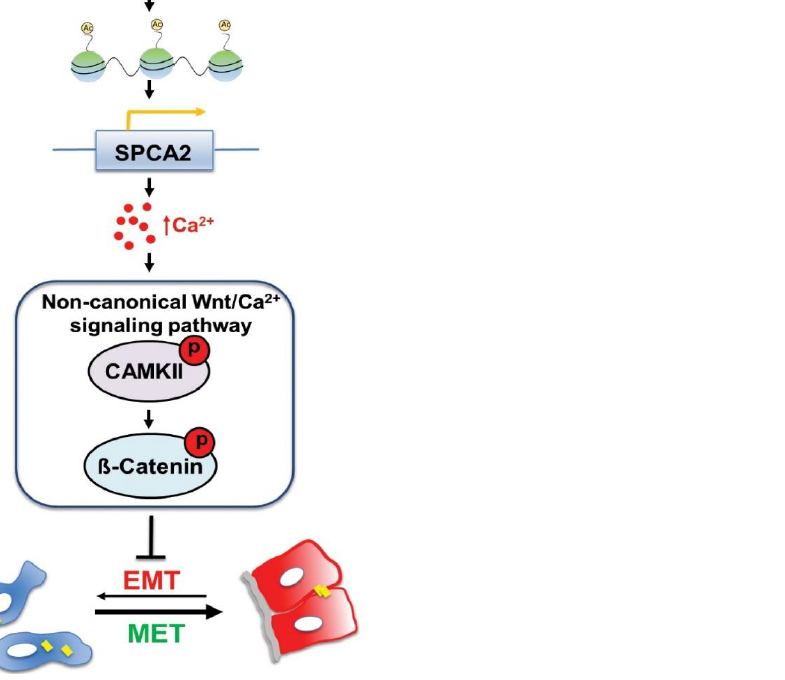
Figure 7. Epigenetic modulation of SPCA2 in TNBC reverses EMT through Ca 2+ /Wnt signaling. Breast cancer cells undergo reversible transitions between mesenchymal state, characterized by low cytosolic Ca 2+ (blue) and detached junctional protein E-cadherin (yellow bars), and epithelial state, characterized by higher resting Ca 2+ (red), attachment to the basement membrane (gray), and cell-cell junctions (yellow). Previous work showed that ectopic expression of SPCA2 in TNBC cells increases cytosolic Ca 2+ and E-cadherin expression to promote epithelial phenotypes. In this study, we show that HDAC inhibitors (vorinostat and romidepsin) increase histone acetylation leading to increased SPCA2 transcription, which in turn elevates resting Ca 2+ by activation of store-independent Ca 2+ entry. Ca 2+ activates non-canonical Wnt signaling by phosphorylating CAMKII and β -catenin, turning Wnt OFF. This blocks EMT and promotes